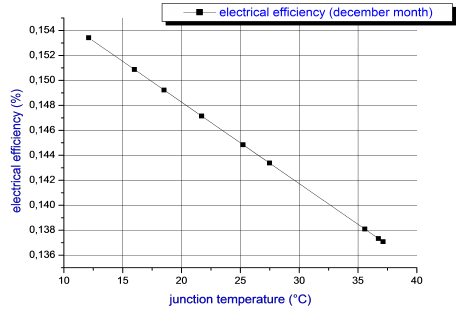
Fig. 11: Temporal evolution of the energy produced by the generator for di(cid:27)erent altitudes for n = 228 and under a pure